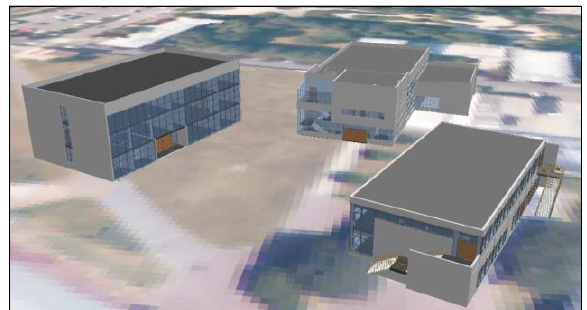
Figure 2 : BIM Models of 3